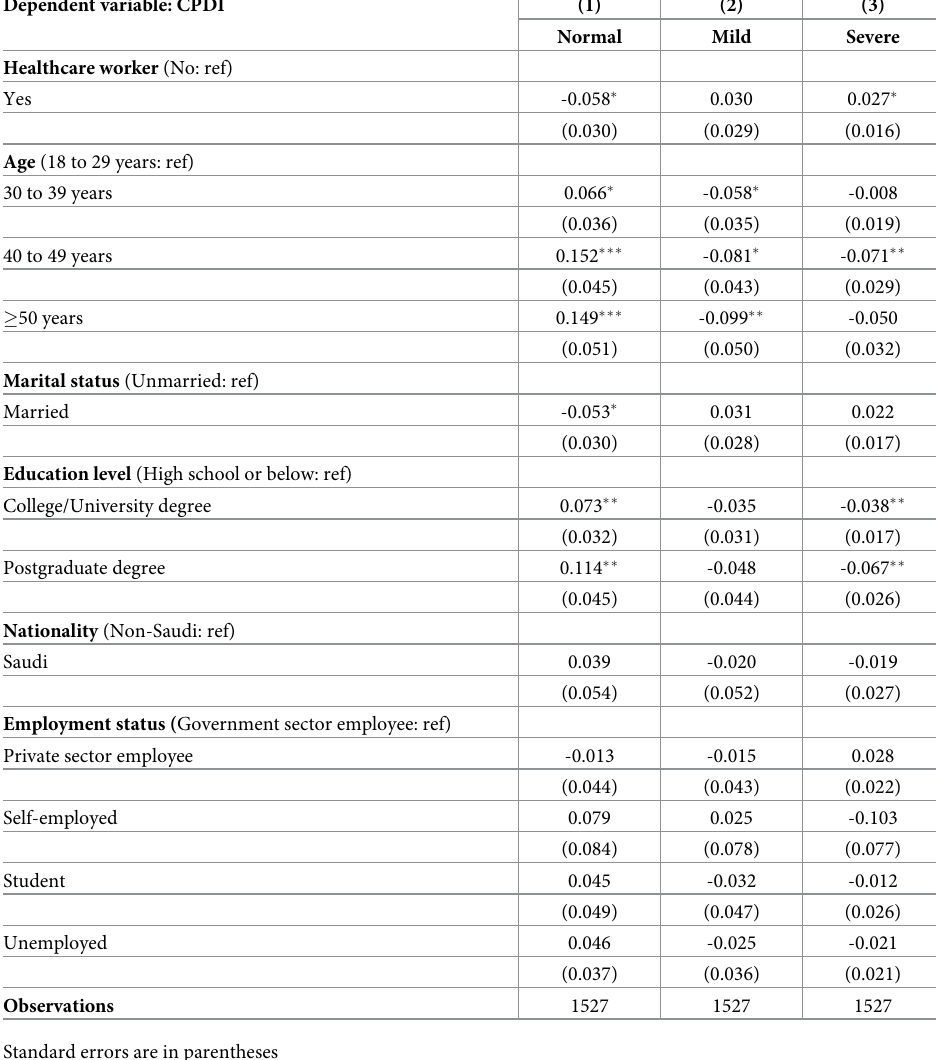
Table 2. The marginal effects of sociodemographic characteristics on distress level (N =